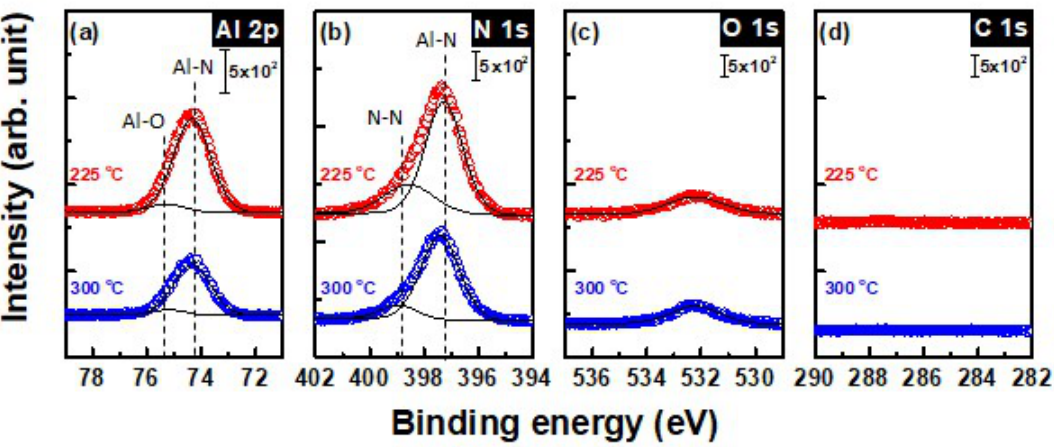
Figure 5. High resolution X-ray photoelectron spectroscopy (XPS) ( a ) Al 2p, ( b ) N 1s, ( c ) O 1s, and ( d ) C 1s spectra of AlN thin film deposited at 225 and 300 °C.